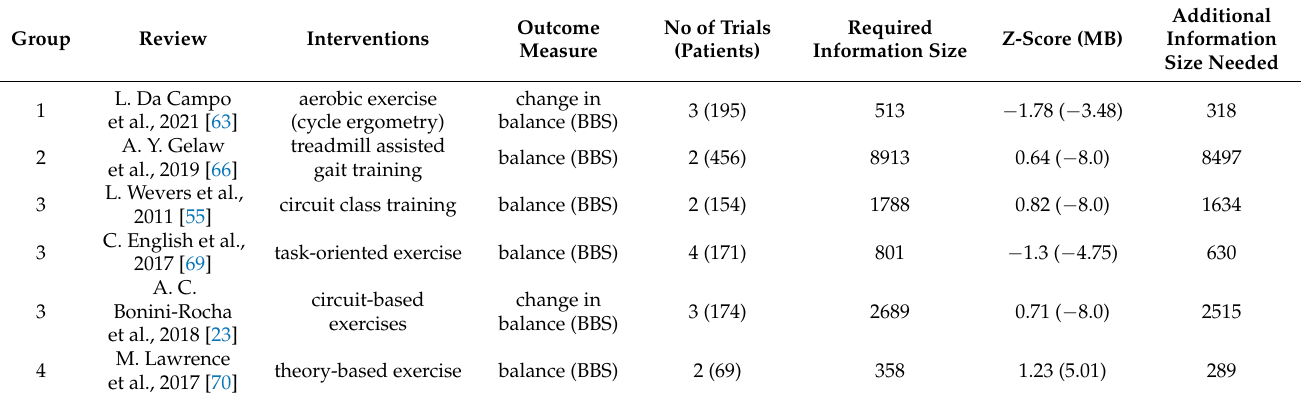
Table 7. Studies with absence of evidence on balance function